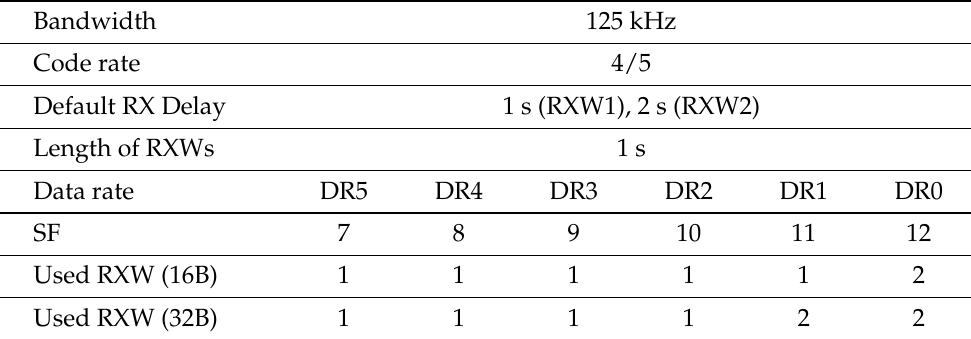
Table 7. LoRa parameter configurations.